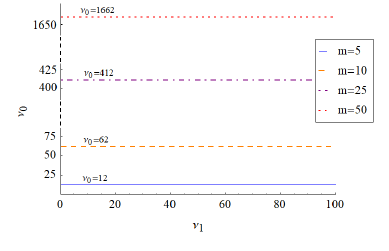
Figure 2. Boundary lines for comparison of T 1 and T 4